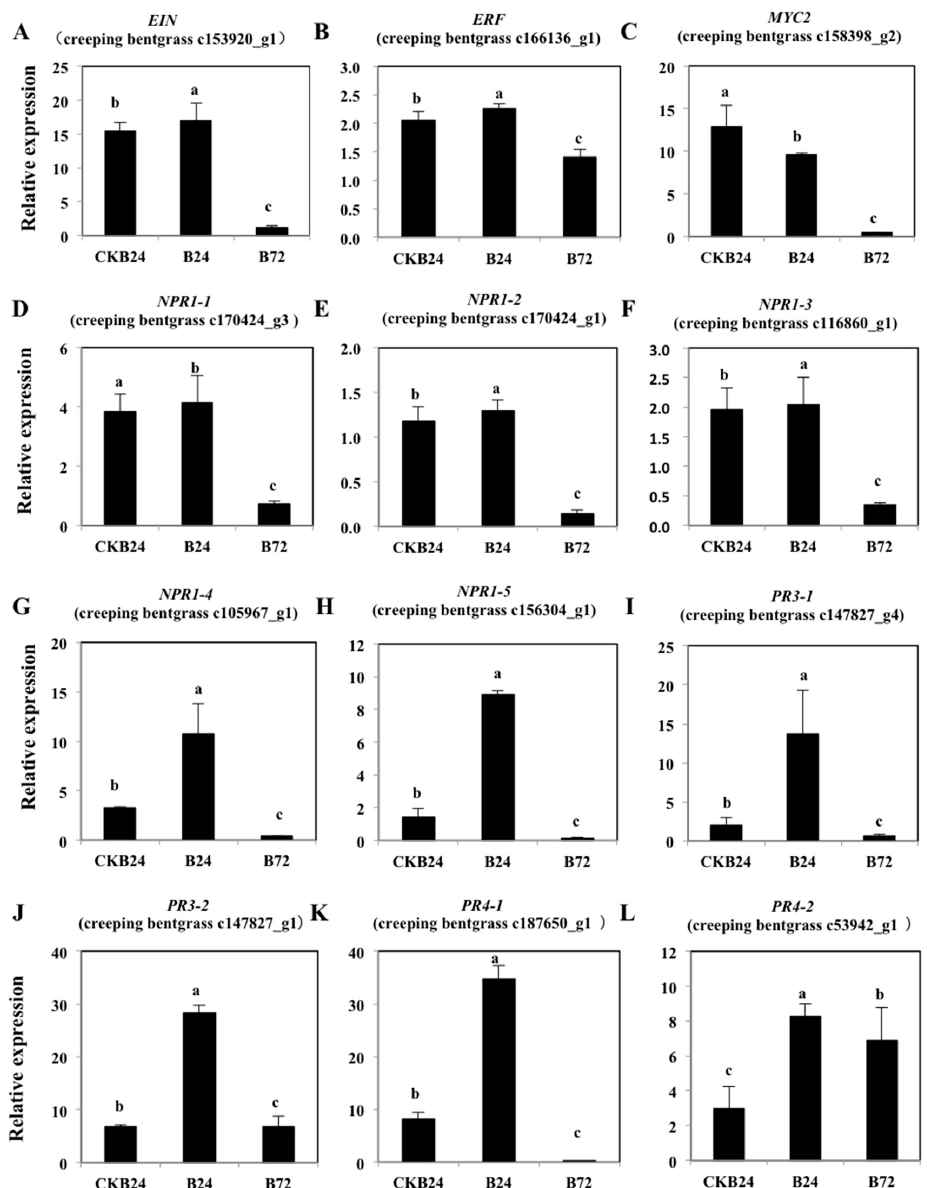
Figure 9. The qRT-PCR analysis of creeping bentgrass ET-responsive genes ( EIN in subfigure A , ERF in subfigure B, MYC2 in subfigure C and NPR1 in subfigure D-H ) and defense-related genes ( PR - 3 in subfigure I,J and PR - 4 in subfigure K,L ) in the ISR response among different treatment samples (NB24, CKB24, B24 and B72). Results represent mean fold increases (x-fold) in mRNA levels ± standard deviation relative to those of at NB24 treatment) obtained from three independent experiments. Lowercase letters above the columns are used to indicate statistically different groups ( p < 0.05).